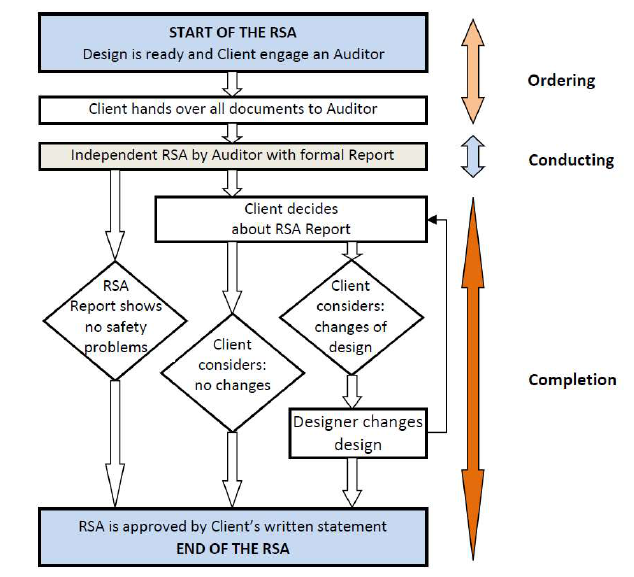
Figure 1. Working diagram of the process for implementing